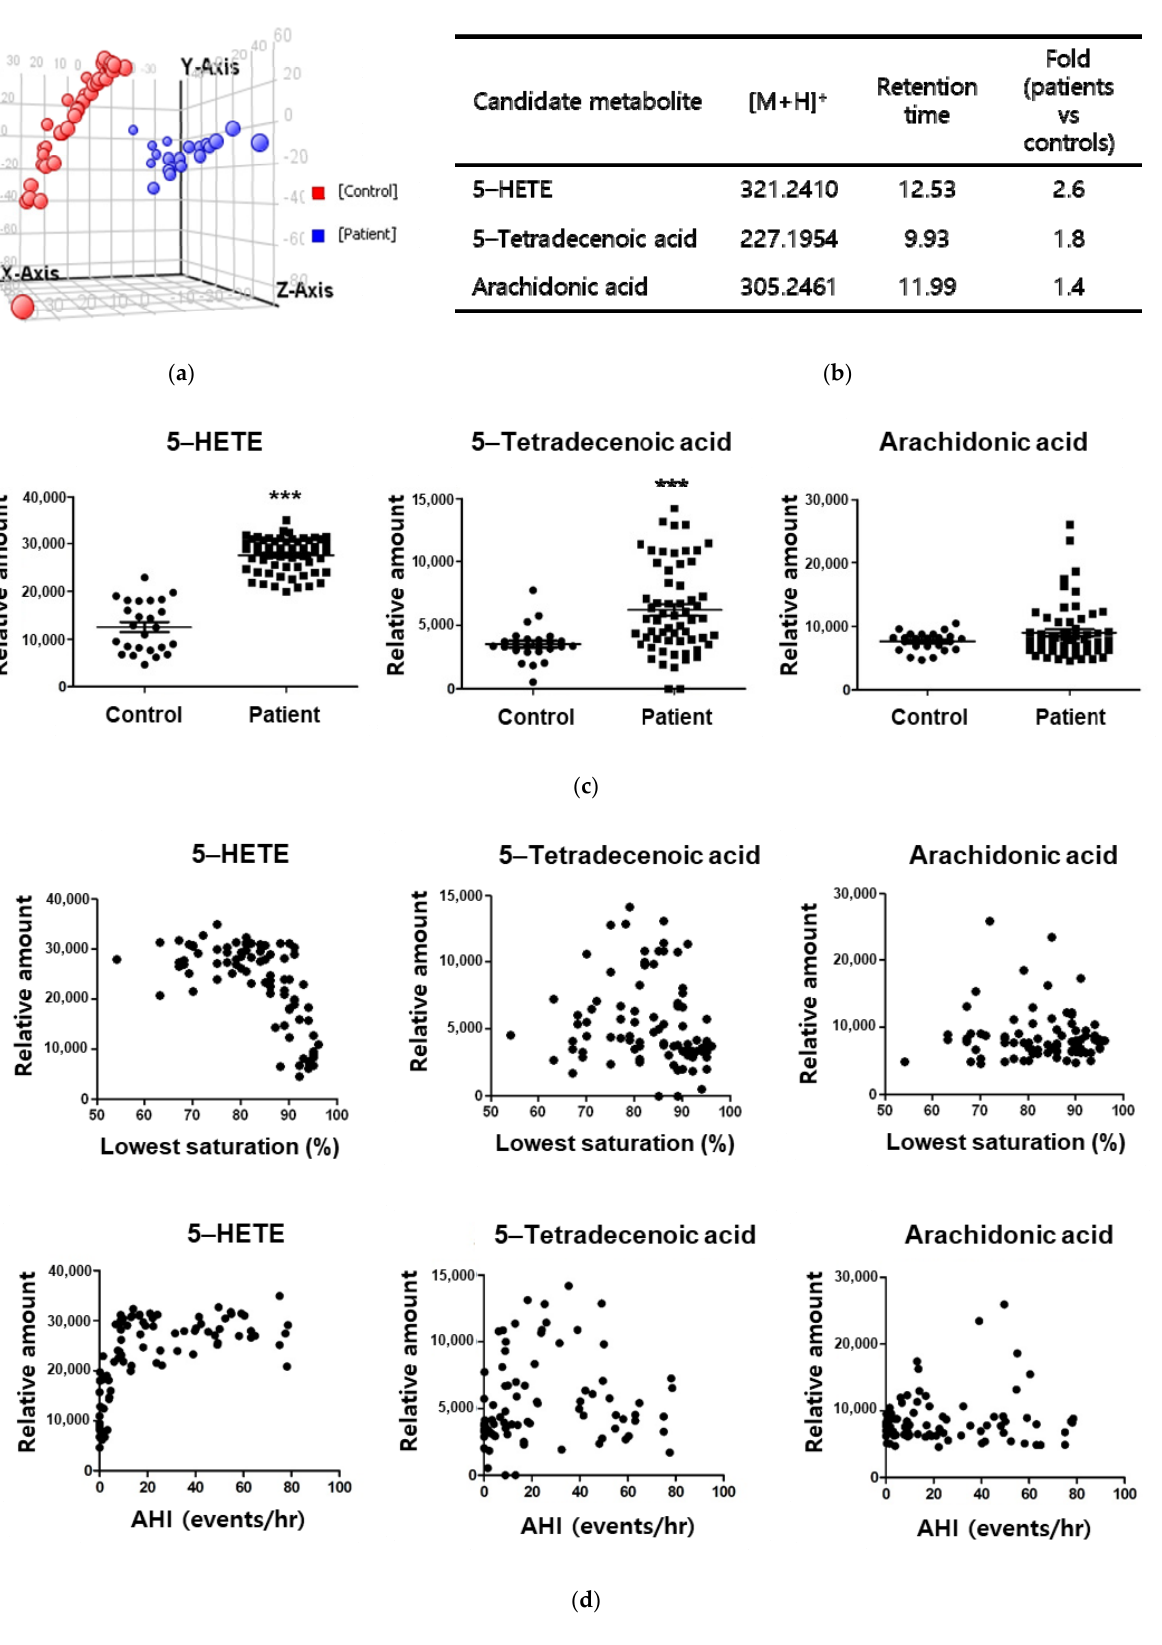
Figure 1. Identification of 5-HETE as a hypoxic biomarker in the obstructive sleep apnea syndrome. ( a ) Results of the partial least squares discriminant analysis of urine specimens from patients with the obstructive sleep apnea syndrome and